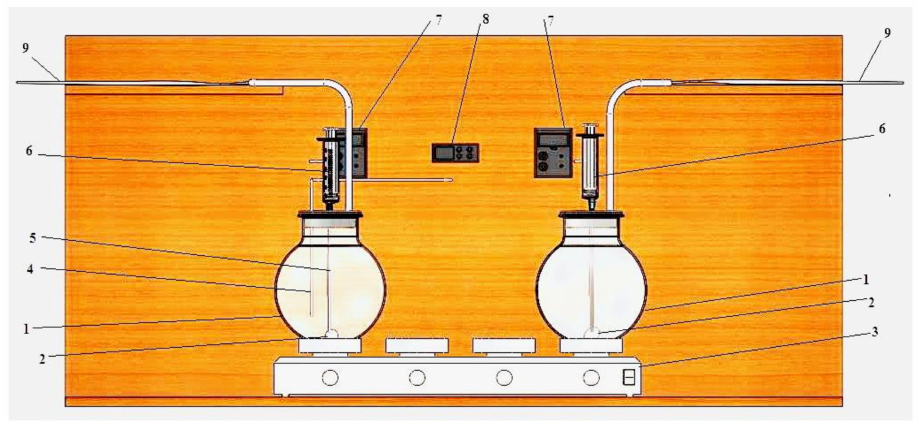
Figure 1. Schematic of the components of the 5 L volume test rig.